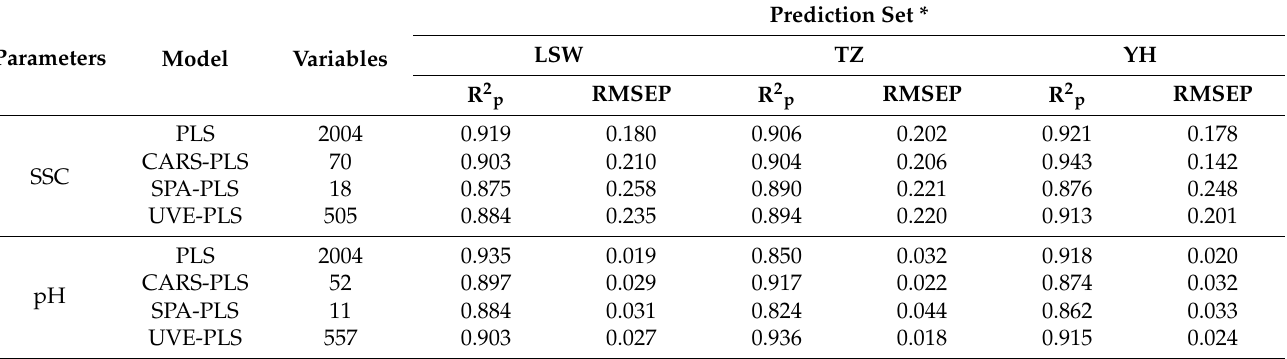
Table 6. Prediction results of different PLS models for the prediction set of SSC and pH of ‘Dangshan’ pears from various